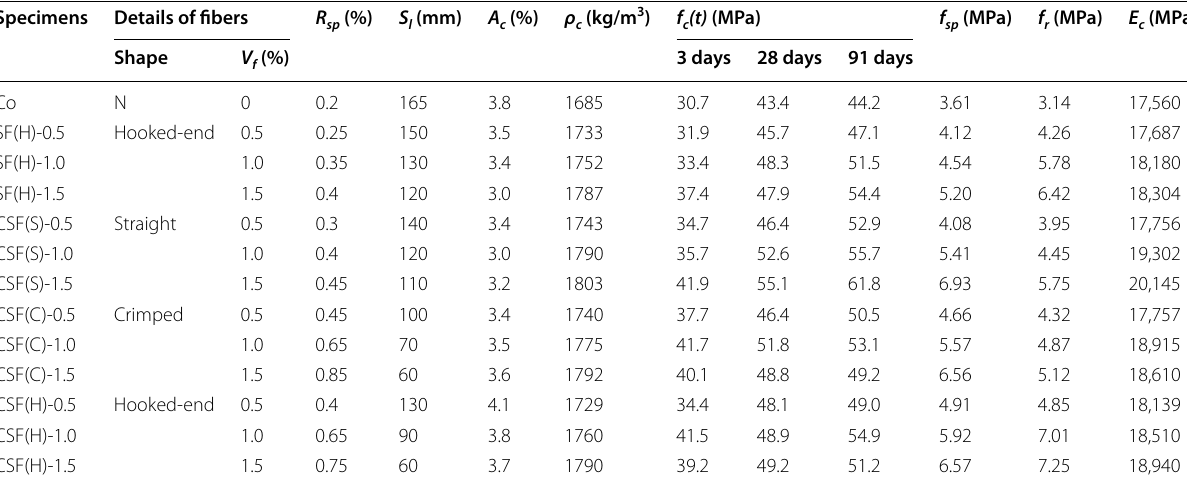
Table 4 Details of test specimens and summary of test